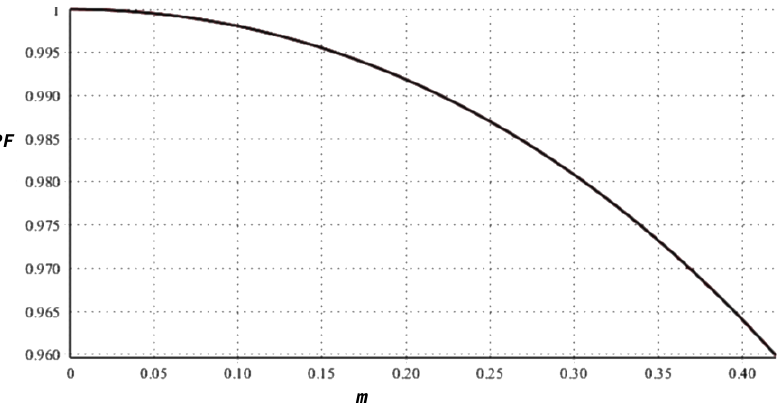
Figure 8. PF of the topology vs the gain ( m ).